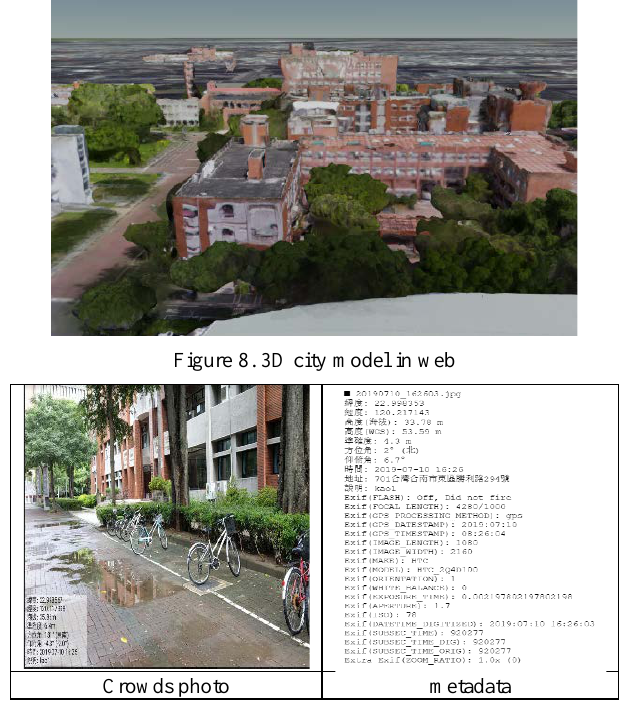
Figure 9. Files uploaded by the crowd